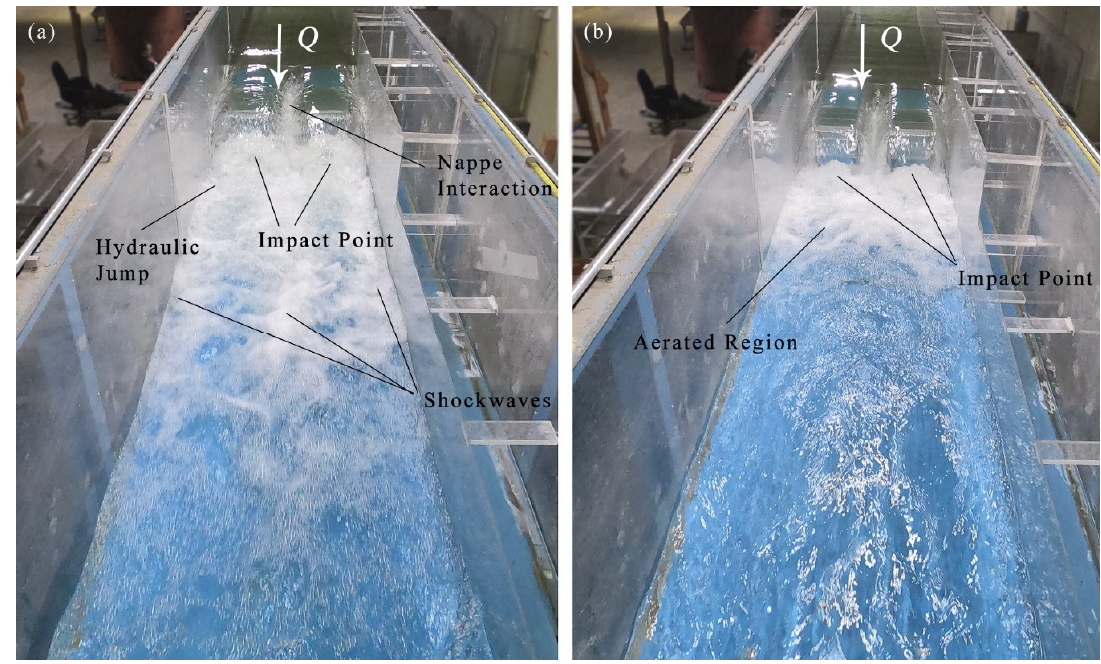
Figure 6. Downstream flow field of Type A PK weir for ( a ) H/P = 0.23 and ( b ) H/P = 0.12.